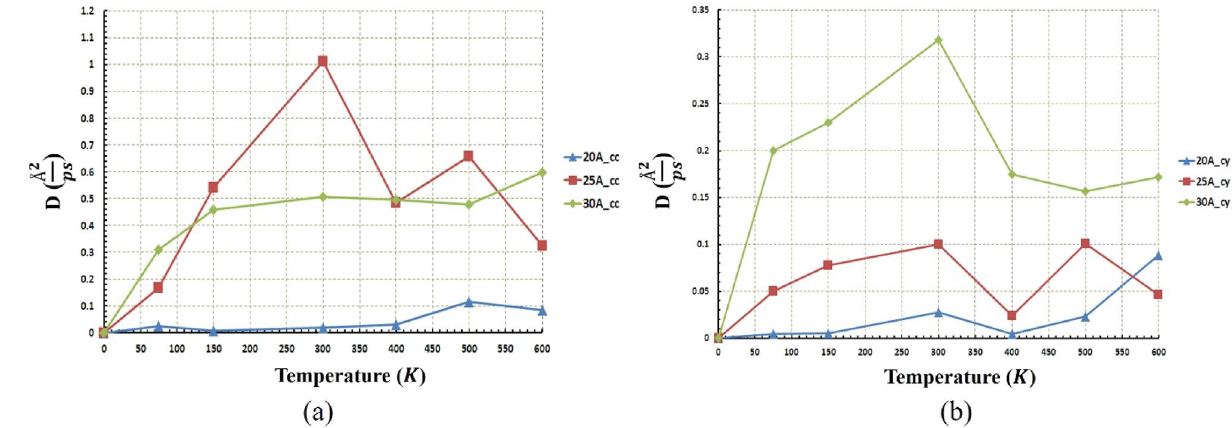
Figure 11. Diffusion coefficient of the nanocar at different temperatures and radii ( a ) for the concave (cc) substrates and ( b ) for the cylindrical (cy) substrates. The diffusion coefficient in concave geometry for almost all 2 ) , but for cylindrical geometry only for the radius of 30 Å , the diffusion coefficient is radii is higher than 0.01 ( Å ps 2 ) . higher than 0.01 ( Å ps